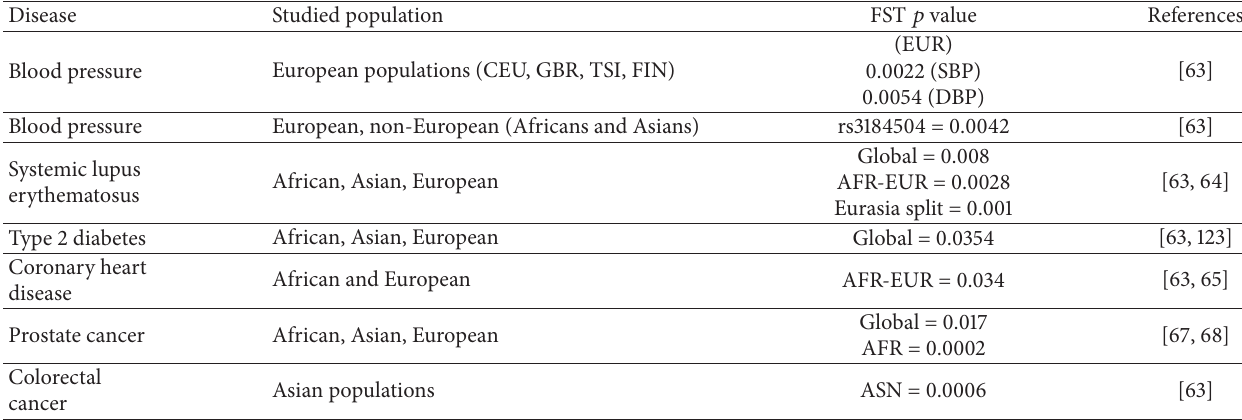
Table 1: Description of natural selection signature on complex diseases in human